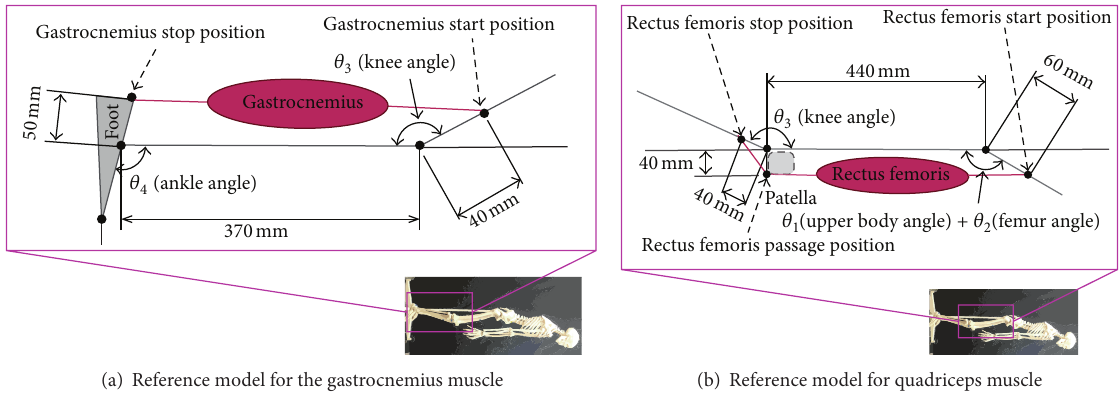
Figure 3: Reference models for calculating normalized biarticular muscle